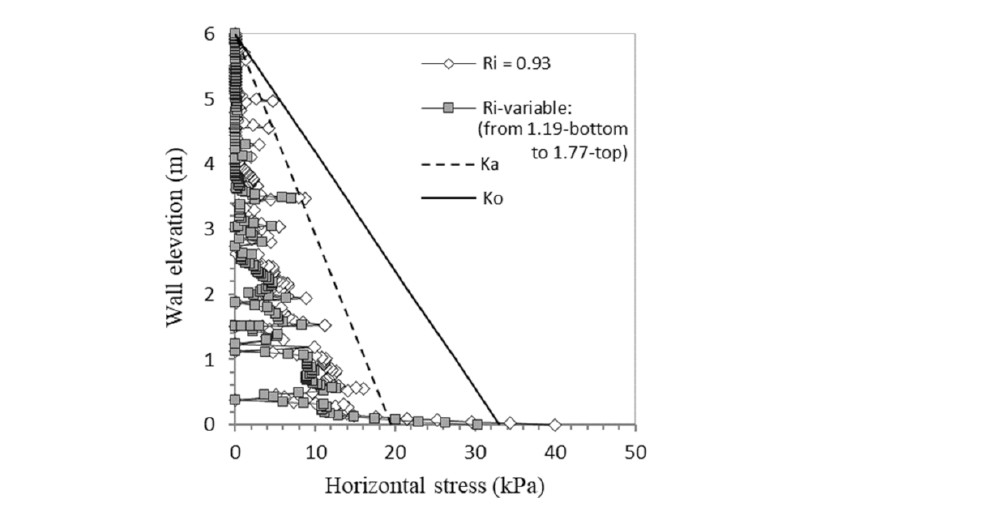
Figure 24. Horizontal earth pressure at the facing for the D i = 0.6 H case at the end of construction (EoC) using different polymeric–soil interface strengths and stiffness ( R i -factor) for the D i = 0.6 H Infrastructures 2022 , 7 , x FOR PEER REVIEW case with no pre-tensioning.